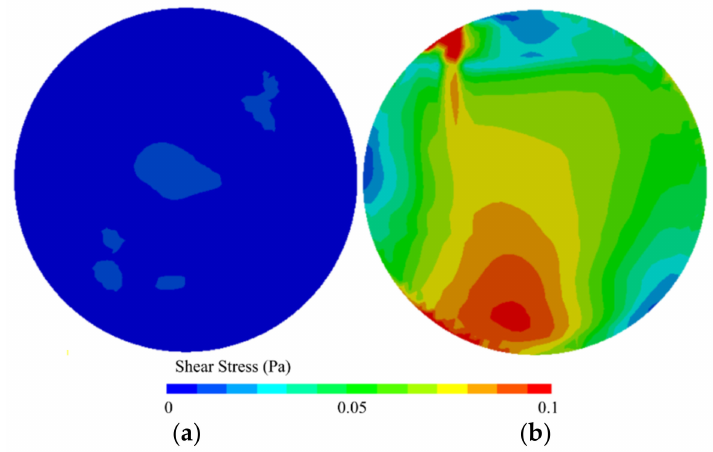
Figure 5. Shear stress magnitudes (Pa) on the bottom of 12-well microplates shaken at ( a ) 40 and ( b ) 180 rpm (orbital diameter of 25 mm, liquid volume of 3 mL, and temperature of 25 ◦ C). Adapted from Gomes et al. [78].